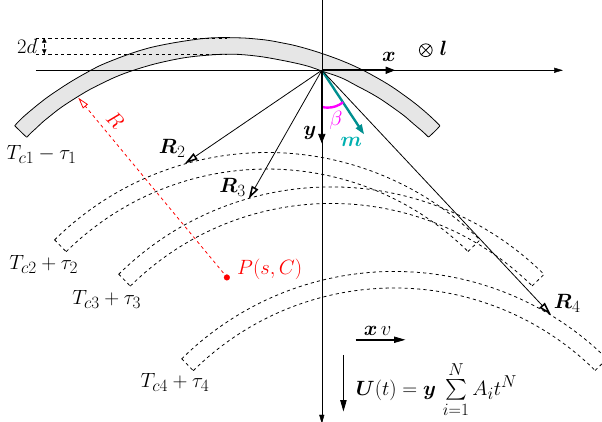
Fig. 6. MP as a parabolic layer, in cross-sections at successive moments. The unit vector l , indicating the invariant direction, points into the paper. The Cluster satellites are located at R i ,i = 1 ... 4, with R 1 ≡ 0. At the initial time, T c 1 − τ 1 , the parabola describ- ing the MP leading edge has the apex at P(s,C) , and encounters the first satellite at the origin; at the other three times shown, at T ci + τ i ,i = 2 ... 4, the MP trailing edge is detected by the second, third and fourth satellite, respectively. According to the model, the MP primary movement, with a polynomial time dependence for ve- locity, takes place along y , parallel to the parabola’s axis. The sec- ondary movement, allowed in one variant of the model, occurs with constant velocity in the perpendicular direction. Details about the quantities shown in this figure are discussed in Appendix A.